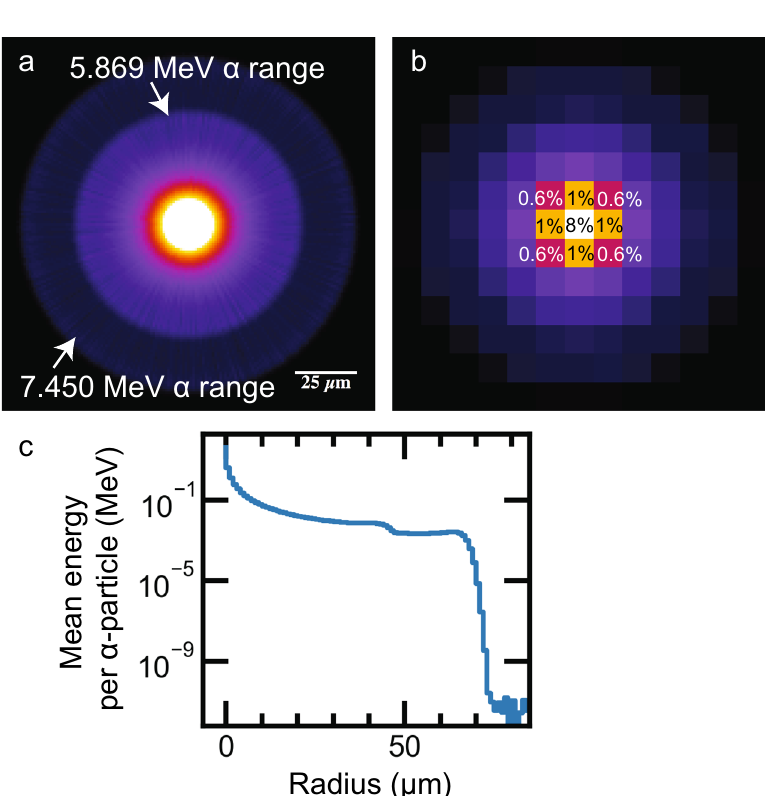
Figure 3. Monte Carlo energy deposition kernel for 211 At alpha-particles in water [10 7 events, GEANT4 36 ]. ( a ) 1-µm voxel kernel (151 × 151 × 151 µm) showing two alpha-decay pathways for 211 At. ( b ) Kernel with percentage energy deposition in voxels binned to 12 µm. Energy deposition falls rapidly beyond adjacent 12-µm tissue slices. ( c ) Semi-log radial profile of ( a ) normalized to one alpha-particle, showing fall-off with